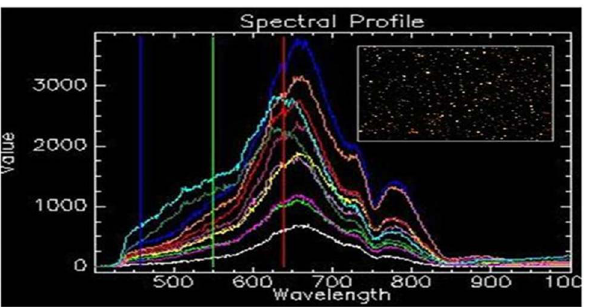
Figure 6. The spectral profile of 14 nm citrate-capped gold nanoparticles. ( A ) The profile was collected from ten randomly selected nanoparticles (singularly dispersed and aggregated AuNPs). ( B ) The insert indicates the image obtained using DAGE